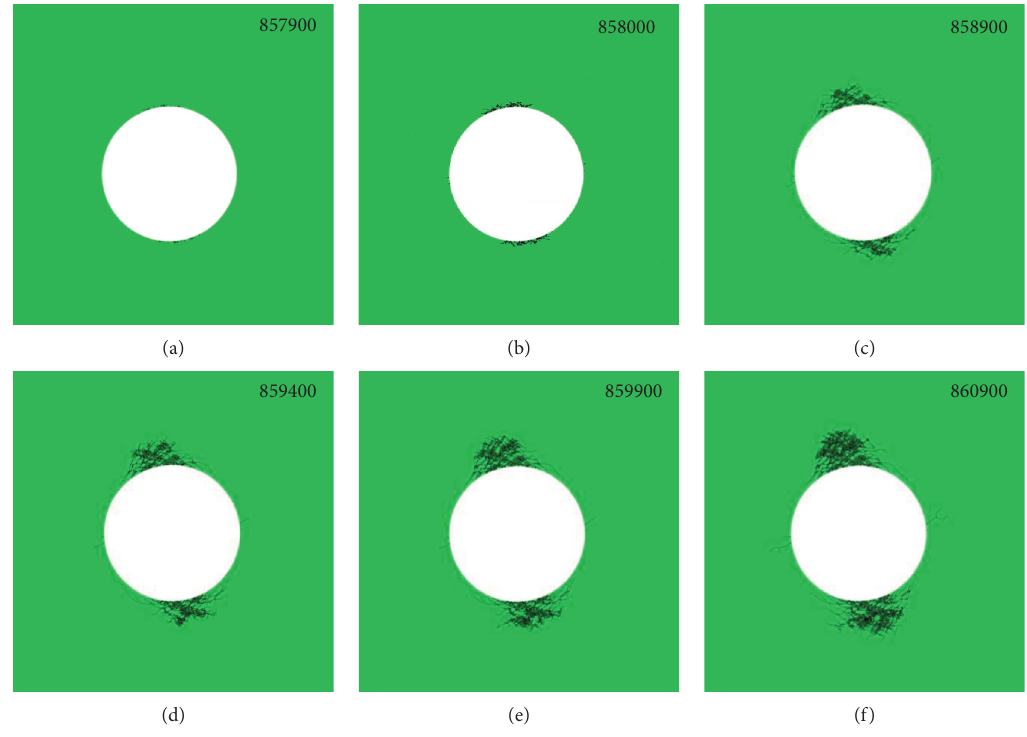
Figure 8: The schematic diagram of fracture evolution during excavation.